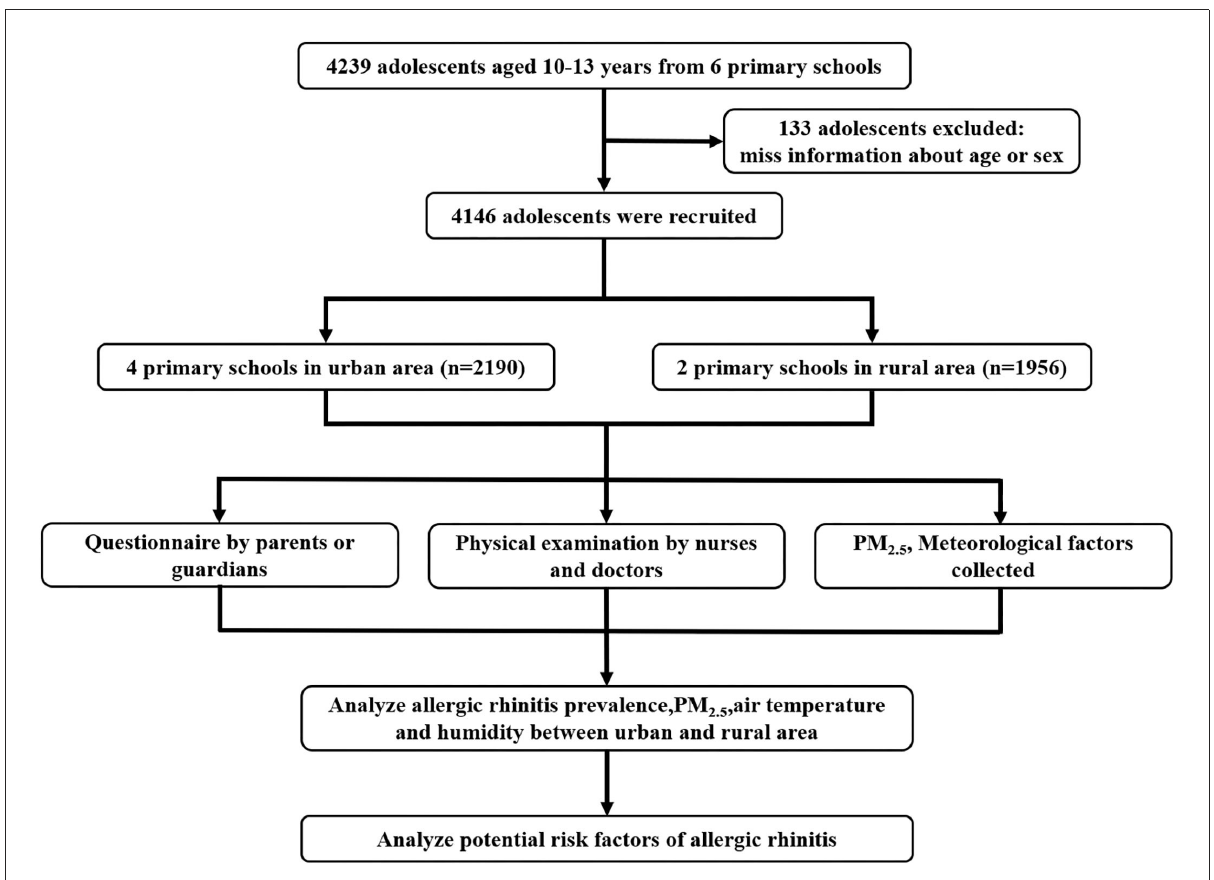
FIGURE1 Flowchart of the